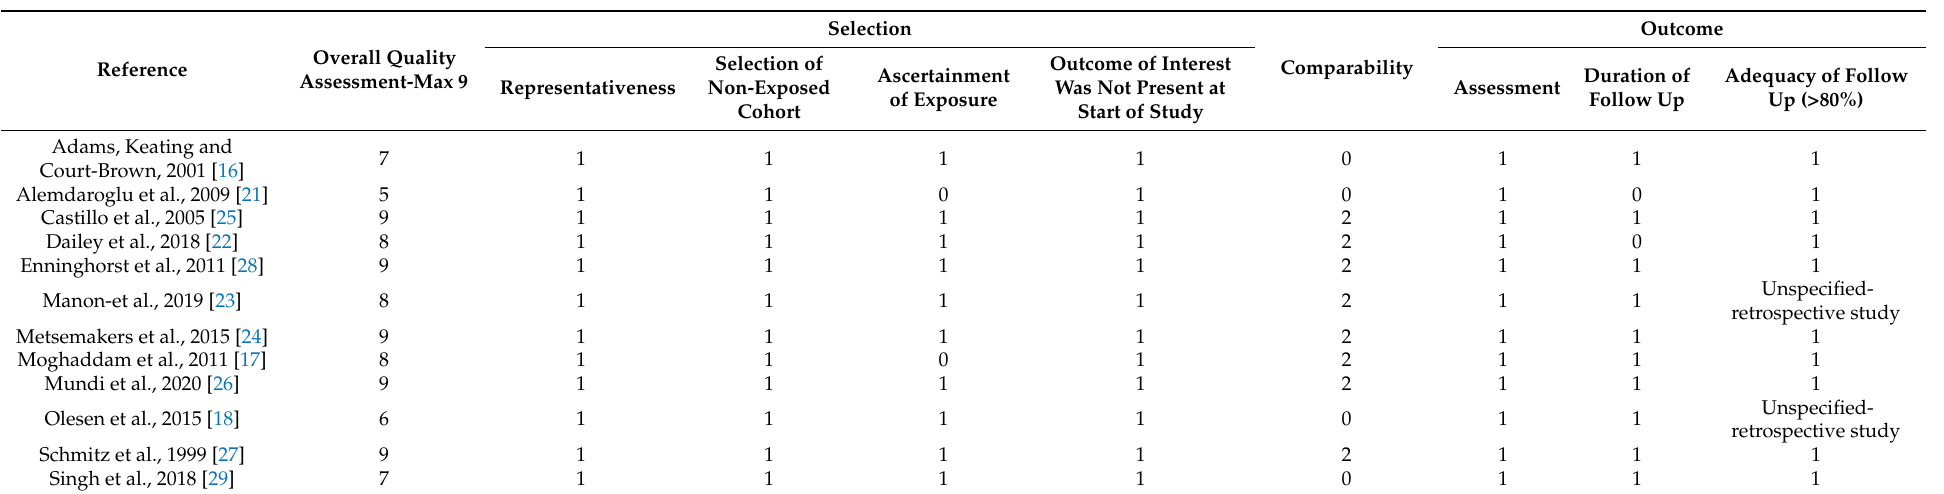
Table 3. Quality Assessment of the Studies by the Newcastle-Ottawa Scale 18